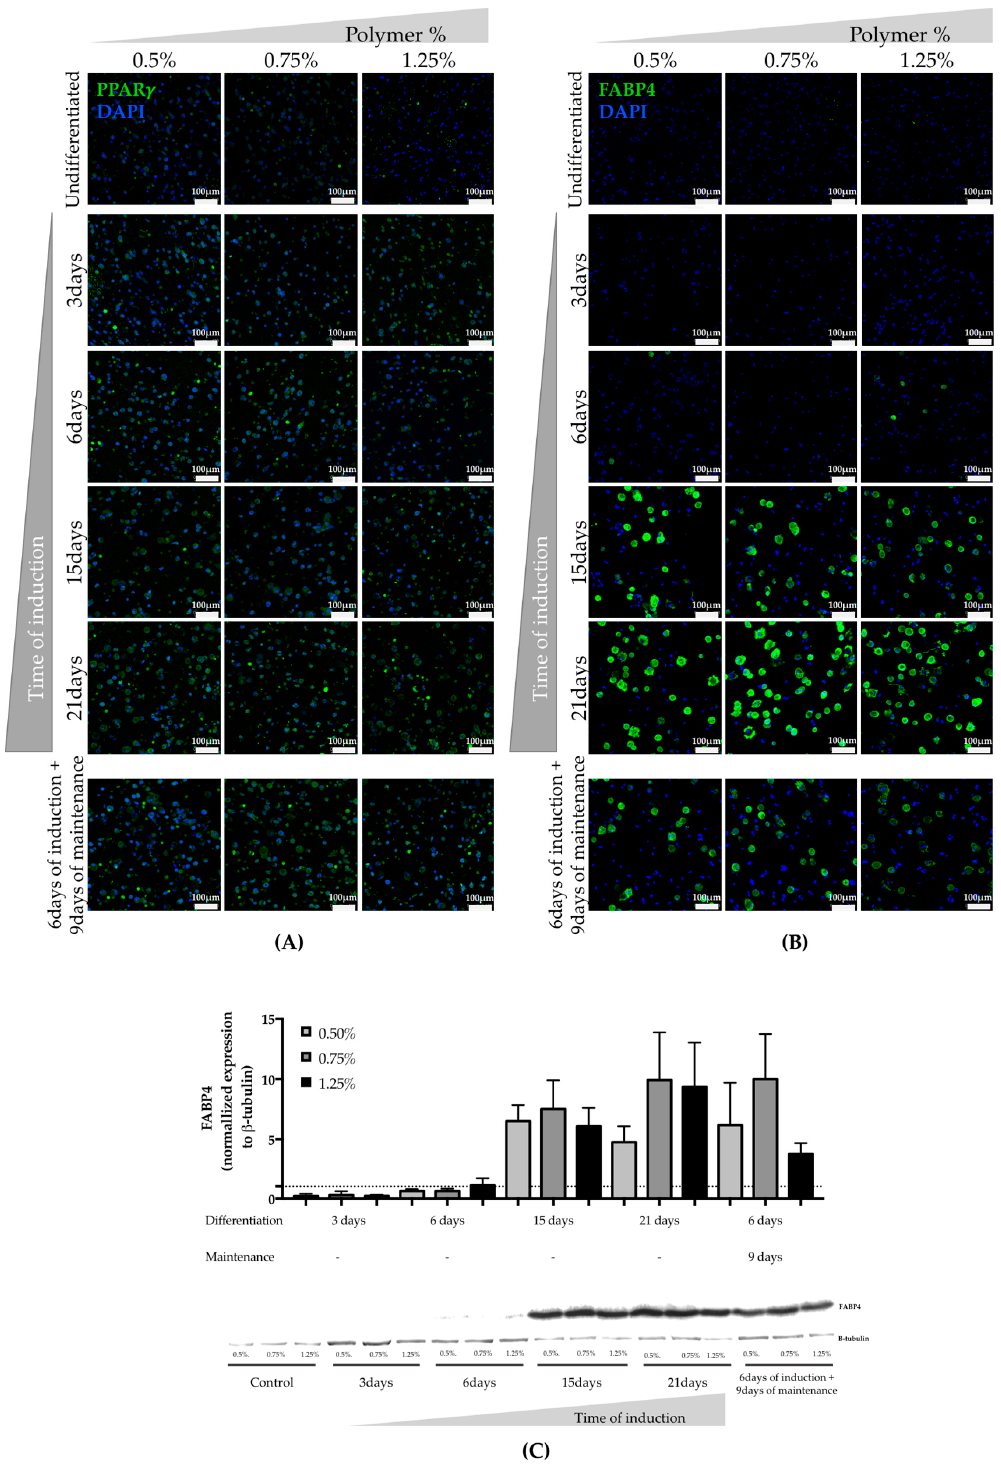
Figure 4. Adipogenic differentiation of human adipose-derived stem cells within gellan gum hydrogel particles with different amounts of polymer along the culture in adipogenic induction medium and after being cultured for six days in induction plus nine days in maintenance media. Representative confocal images of ( A ) PPAR γ and ( B ) FABP4 expression (green). Cells nuclei were labelled with DAPI (blue). ( C ) Representative western Blot analysis of the expression of FABP4. Plotted data was normalized against beta-tubulin expression that was used as loading control. Scale bar 100 µm.